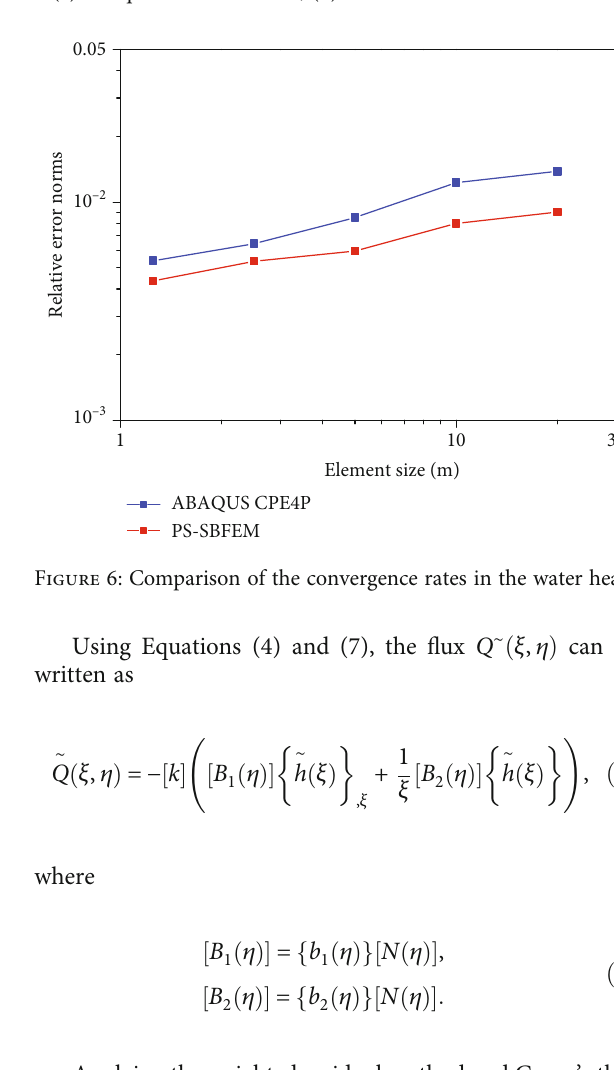
Figure 5: Water head distribution of the dam foundation: (a) Abaqus CPE4P element; (b) PSBFEM element.